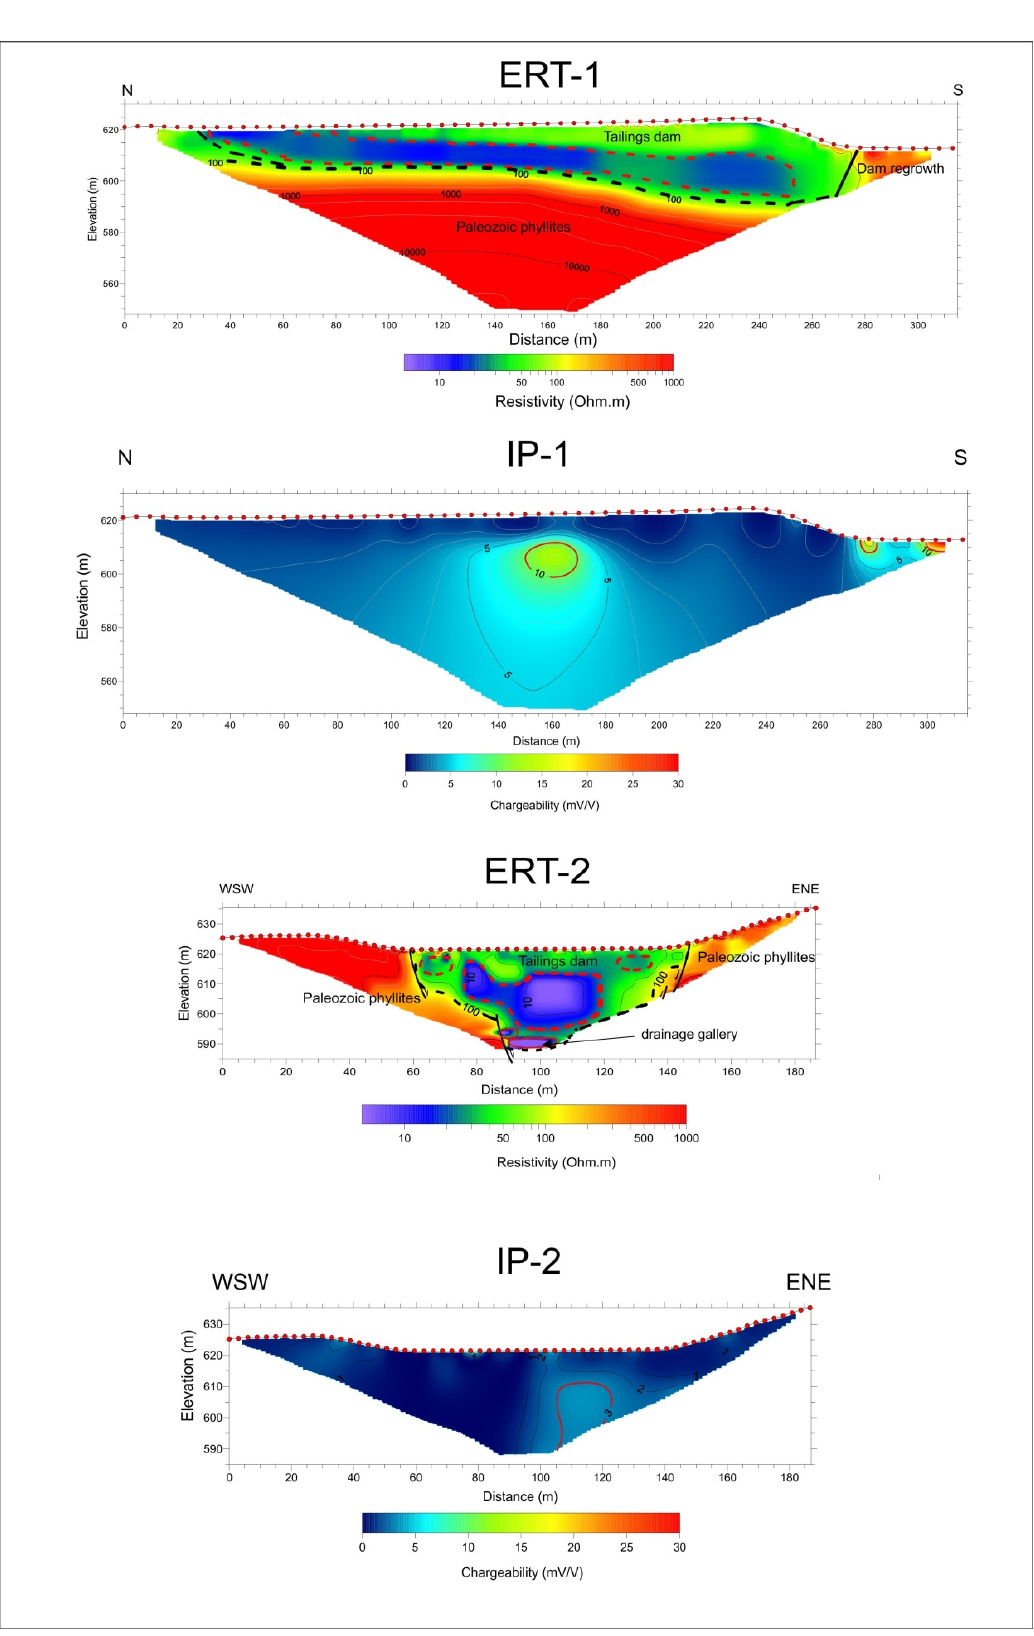
Figure 4. Resistivity models ERT-1 and ERT-2, which show the underlying Palaeozoic (phyllites) with high resistivity values (red colors), and flotation waste with low resistivities (blue and green colors) that indicate wet areas (dashed red line). In induced polarization (IP) models IP-1 and IP-2, low chargeability values are shown as blue and yellow colors and red are associated with the level enriched in metal(oid)s.